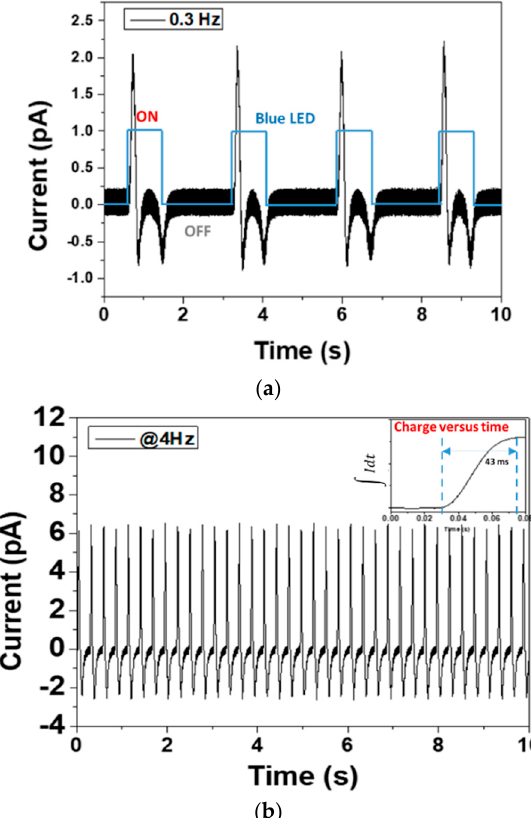
Figure 7. Photocurrent at various frequencies: ( a ) 0.3 Hz, ( b ) 4 Hz, Inset: charge displacement versus time.